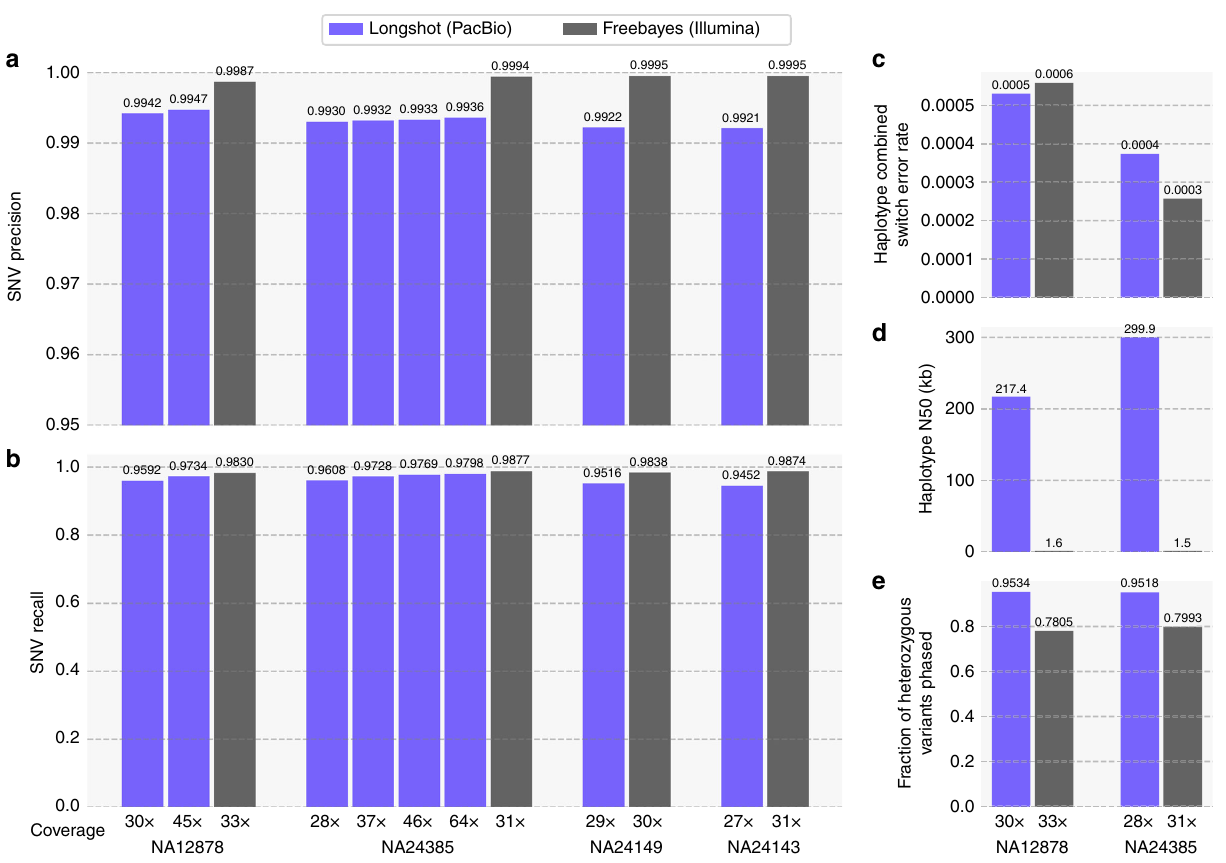
Fig. 2 Accuracy and completeness of LongShot SNV calls on whole-genome SMS data. Longshot was used to call single nucleotide variants (SNVs) using SMS data from the GIAB project for four human genomes: NA12878 (30 ´ and 45 ´ coverage), NA24385 (28 ´ , 37 ´ , 46 ´ , and 64 ´ coverage), NA24149 (29 ´ coverage), and NA24143 (27 ´ coverage). For each individual, variants were also called using FreeBayes applied to (cid:1) 30 ´ coverage Illumina short reads. a Precision of the SNV calls calculated using the GIAB high-con fi dence variant call set. b Recall of the SNV calls. c The combined switch error rate (total rate of switch errors and mismatch errors) of the Longshot and Illumina short-read-based haplotypes. d N50 length of the haplotypes. e The fraction of heterozygous variants phased in each consistently achieve high recall (only 2 – 3% lower than Illumina WGS for the same depth of coverage), while achieving a low false discovery rate (FDR; average = 0 : 7%) was remarkable given the signi fi cantly high error rate of SMS reads ( (cid:1) 10%) compared with Illumina reads.